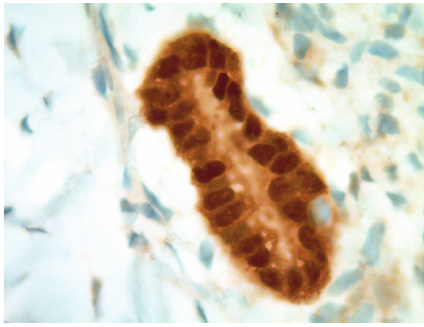
Figure 1: Photomicrograph of tissue section from the patient’s known invasive ductal carcinoma, nuclear grade 2 (Hematoxylin and Eosin [H&E] stain, original magnification 400x).